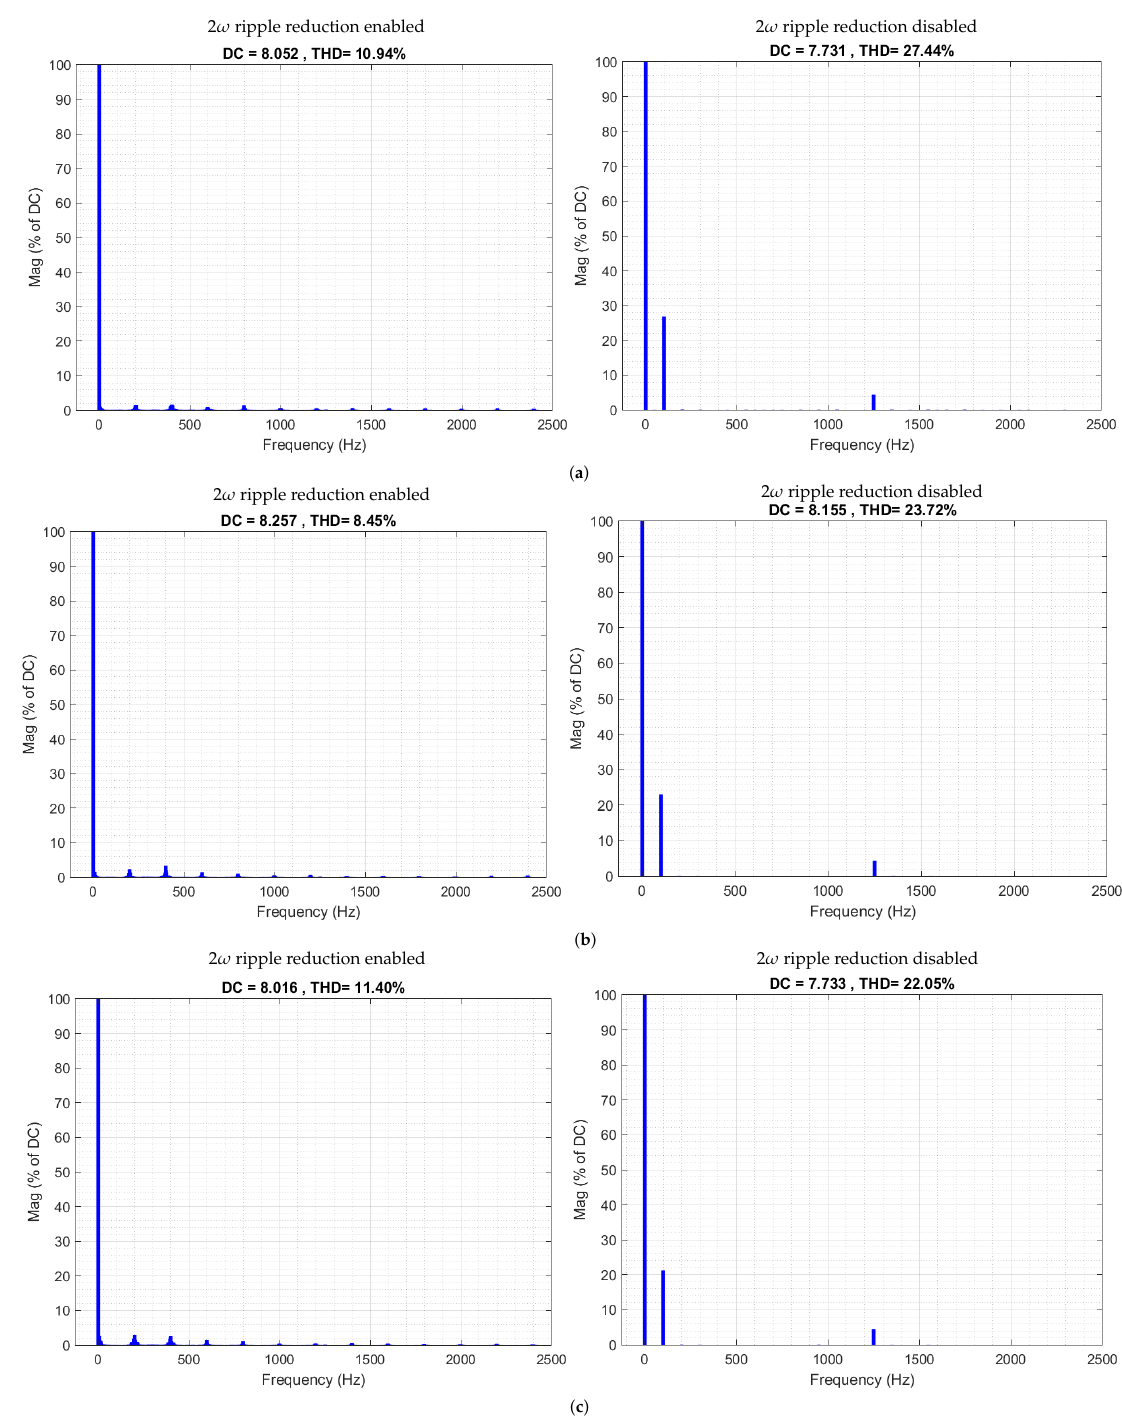
0.5 kVAR; ( b ) P g = 1.5 kW, Q g = 0 −